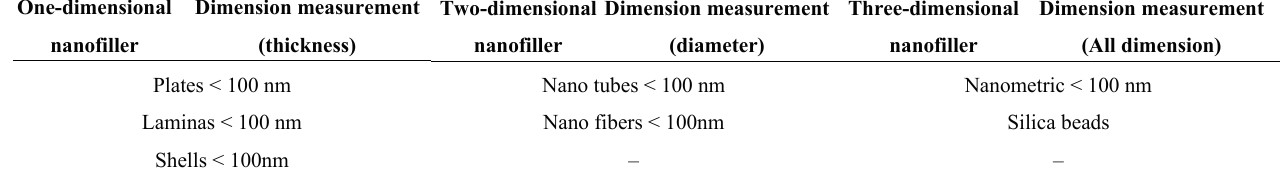
Table 6. Classification of nanofillers with reference [39].